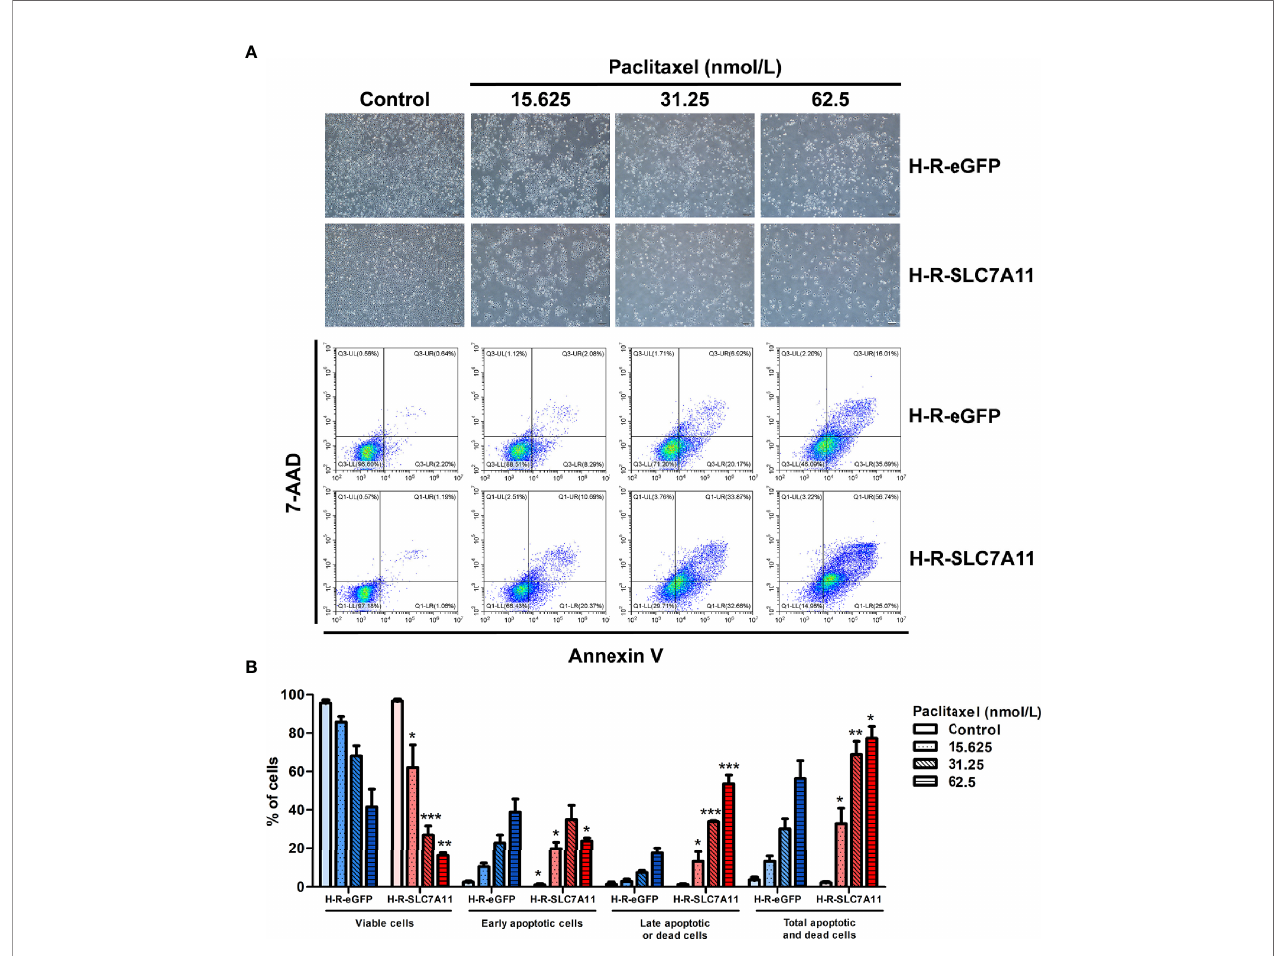
FIGURE 5 | Effects of paclitaxel on the apoptosis of H-R-eGFP and H-R-SLC7A11 cells by PE Annexin V/7-AAD-double staining fl ow cytometry analysis. (A) Representative cell-culture images and fl ow cytometric fi ndings of H-R-eGFP and H-R-SLC7A11 cells treated with gradient concentrations of paclitaxel for 72 hours. The lower left quadrant shows living cells, the lower right quadrant early apoptotic cells, the upper left quadrant non-apoptotic dead cells, and the upper right quadrant shows late apoptotic cells and dead cells; (B) The histogram of apoptosis experiments. Statistical analysis was performed to compare the living cell rate of H-R-eGFP to H-R-SLC7A11 (lower left quadrant), early apoptotic cell rate (lower right quadrant), late apoptotic cell rate, and dead cell rate (upper right quadrant), and total apoptosis and death cell rates (upper left + upper right + lower right quadrant). The statistical analysis in the fi gure was a pair-wise comparison between H- R-eGFP and H-R-SLC7A11 cells treated with the same paclitaxel concentration and the same state of cells (* P < 0.05, ** P < 0.01, *** P <